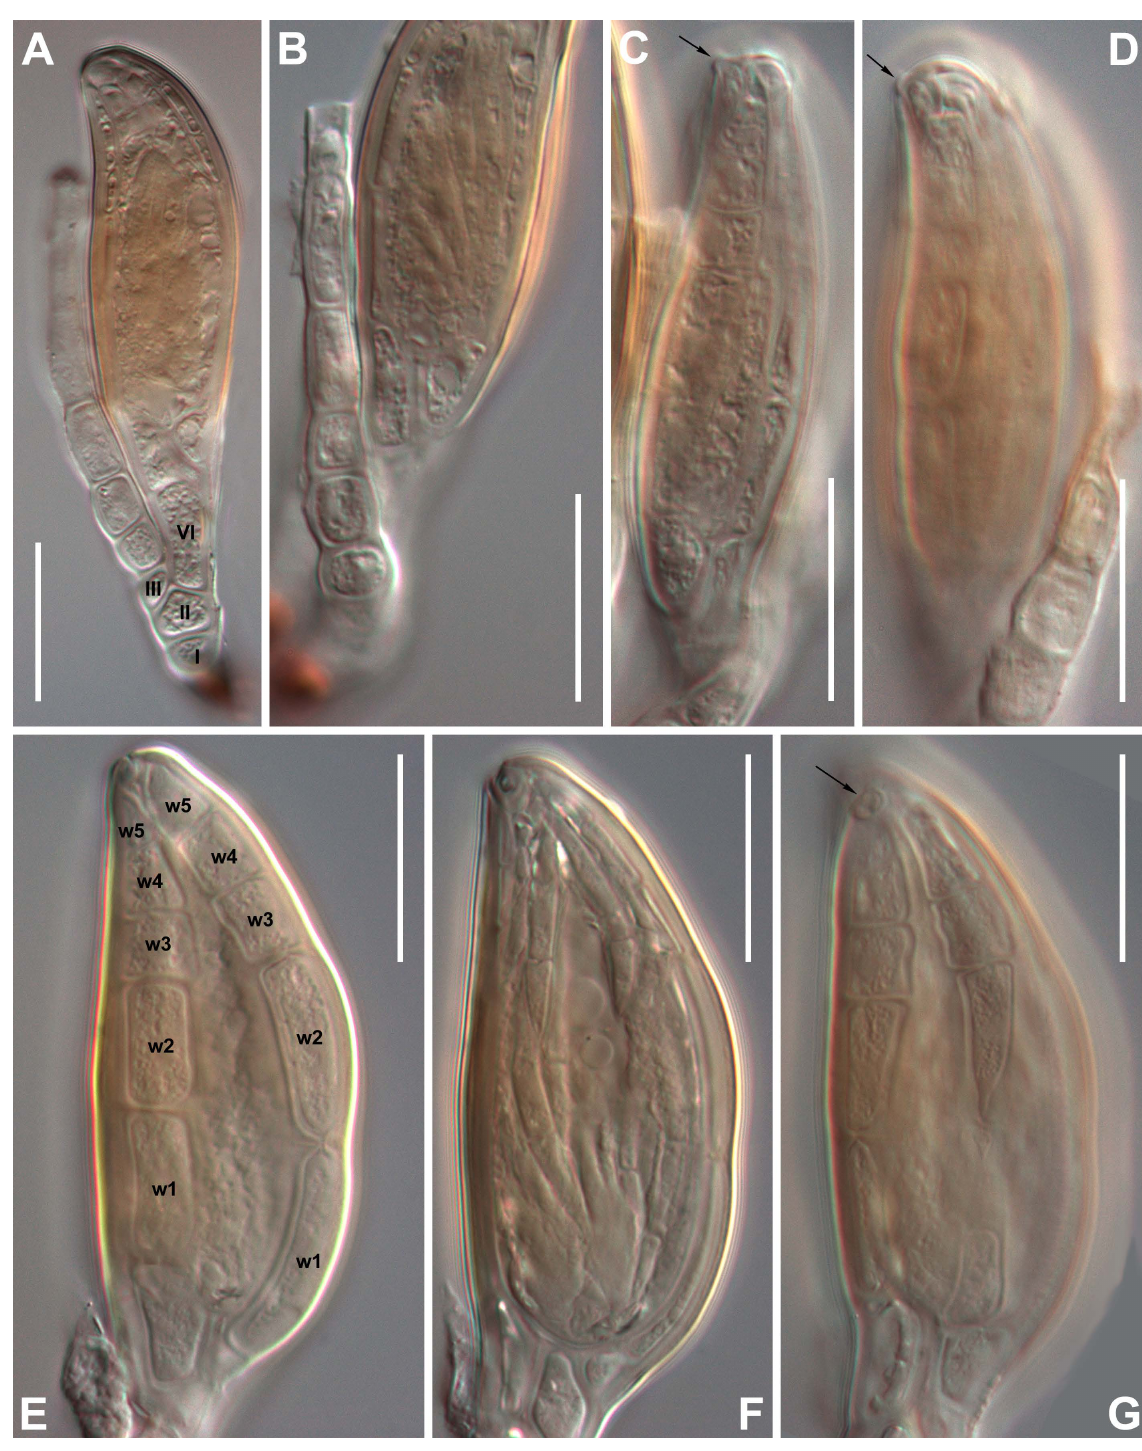
Fig. 50. Cryptandromyces danicus Santam. sp. nov. A . Submature thallus showing cells I, II, III, VI. B . Primary appendage in detail. C – D . Detail in side view with rounded knob at perithecial apex (arrows). E – G . Mature perithecium in detail at three focusing levels (near, middle and far, respectively) to show perithecial wall cells (w ) and trichogyne scar (arrow). Scale bars: 20 µm. Photographs from n slide ZMUC C-F-124167